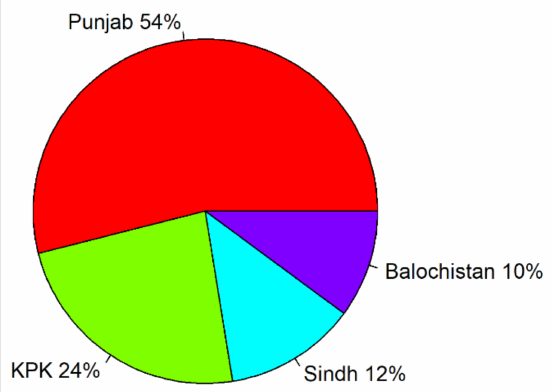
Figure 2. Province-wise distribution of reviewed